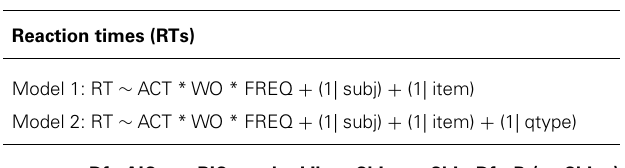
Table 4 | Results of likelihood ratio test comparing models without a random factor QTYPE (model 1) and with a random factor QTYPE (model